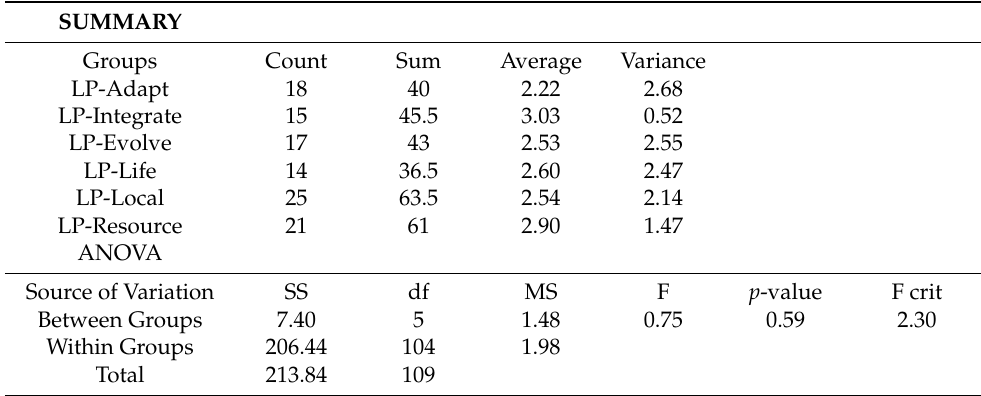
Table 6. Summary table one way ANOVA for